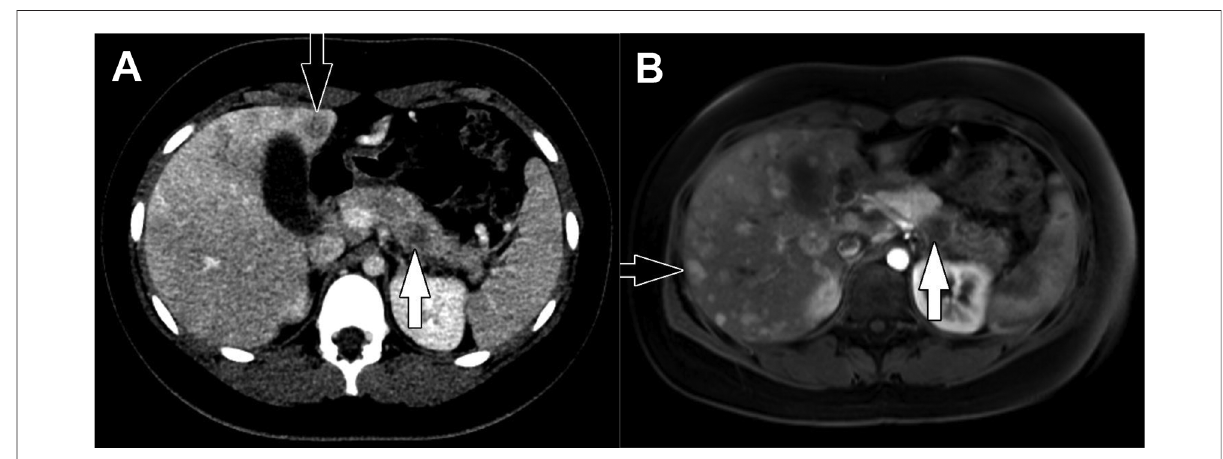
FIGURE 6 Insulinoma. ( A ) Axial CT of the abdomen obtained in the portal venous phase following intravenous contrast material administration shows a hypoenhancing mass in the body of the pancreas (white arrow) with multiple hypoenhancing liver metastases (one indicated by the black arrow). Characteristically, neuroendocrine tumors hyperenhance in the arterial phase following contrast administration but hypoenhancing lesions do occur. ( B ) Axial T1-weighted fat-saturated post-contrast MRI obtained in the arterial phase shows the pancreatic tumor (white arrow) to be hypoenhancing while the multiple liver metastases (one indicated by the black arrow) are hyperenhacing. The tail of the pancreas upstream of the tumor is hypoenhancing due to obstructive pancreatitis related to the tumor.